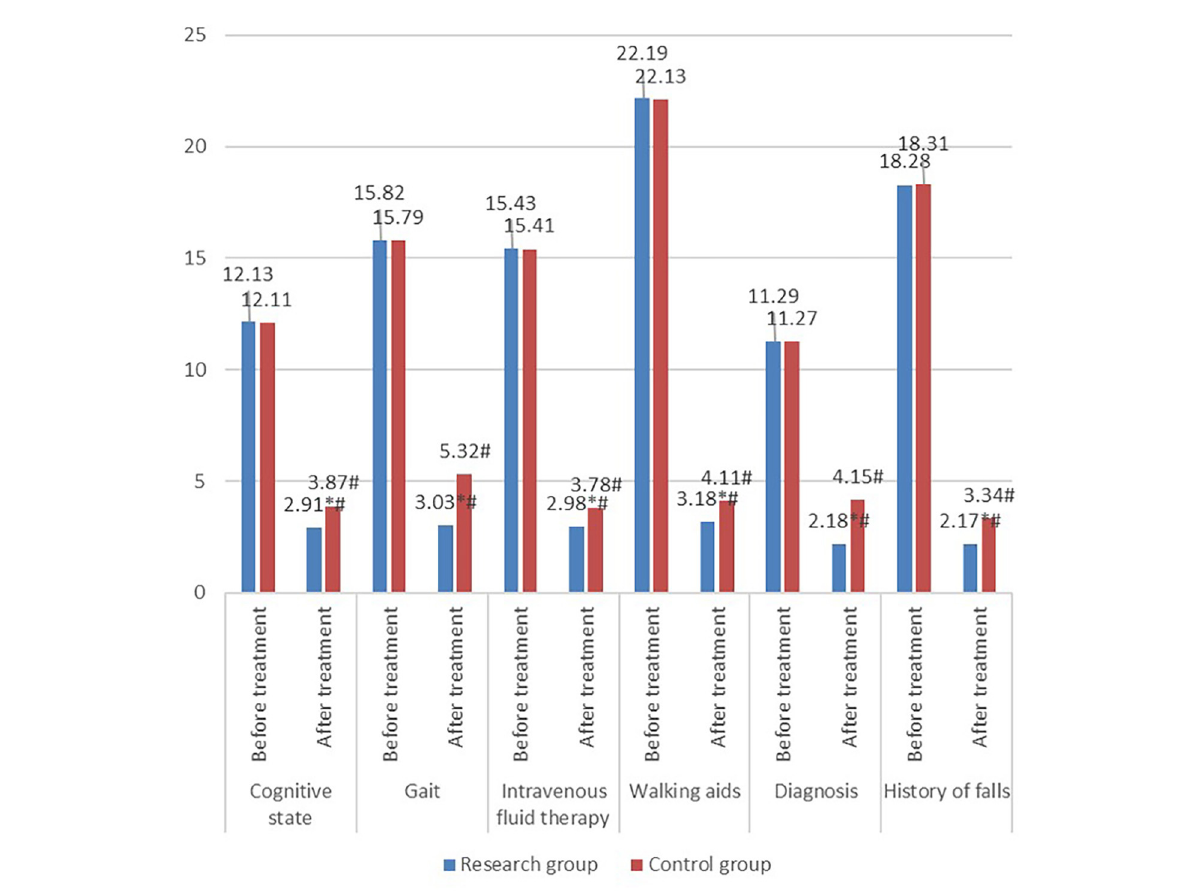
FIGURE4 Comparison of fall risk scores between the two groups. Fall risks in the research group including cognitive state, gait, intravenous therapy fluid, walking aids, diagnosis, and history of falls improved after treatment. Additionally, fall risks of the research group after treatment was significantly better than that of the control group.